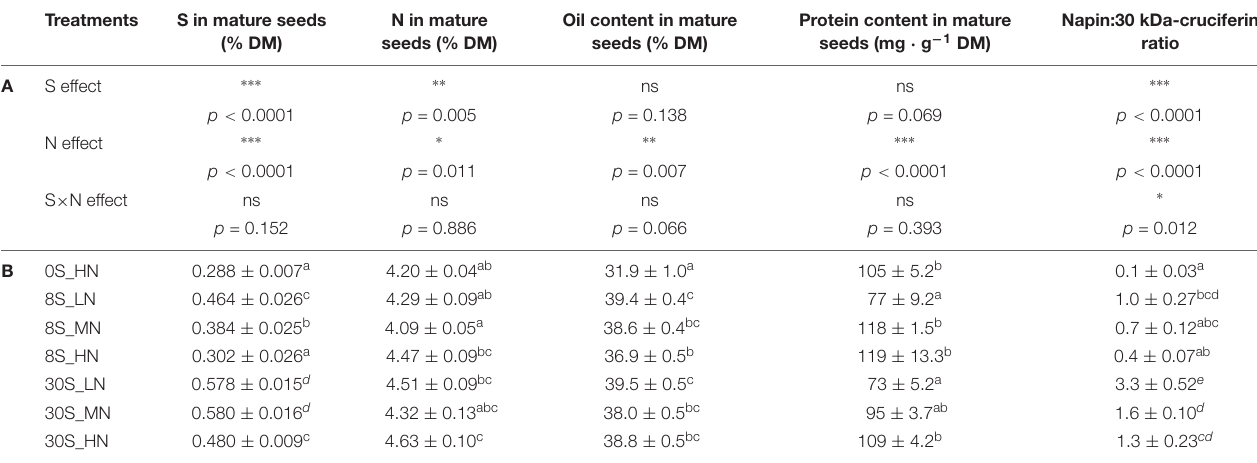
TABLE 3 | S, N, and S × N effects on relative content of S, N, oil, and proteins, and on the ratio of napin:30 kDa-cruciferin in mature seeds (A) and S, N contents (% of DM), oil content (in % of DM, estimated by NIRS), protein content (mg g − 1 DM), and the napin:30 kDa-cruciferin ratio in mature seeds for plants grown under